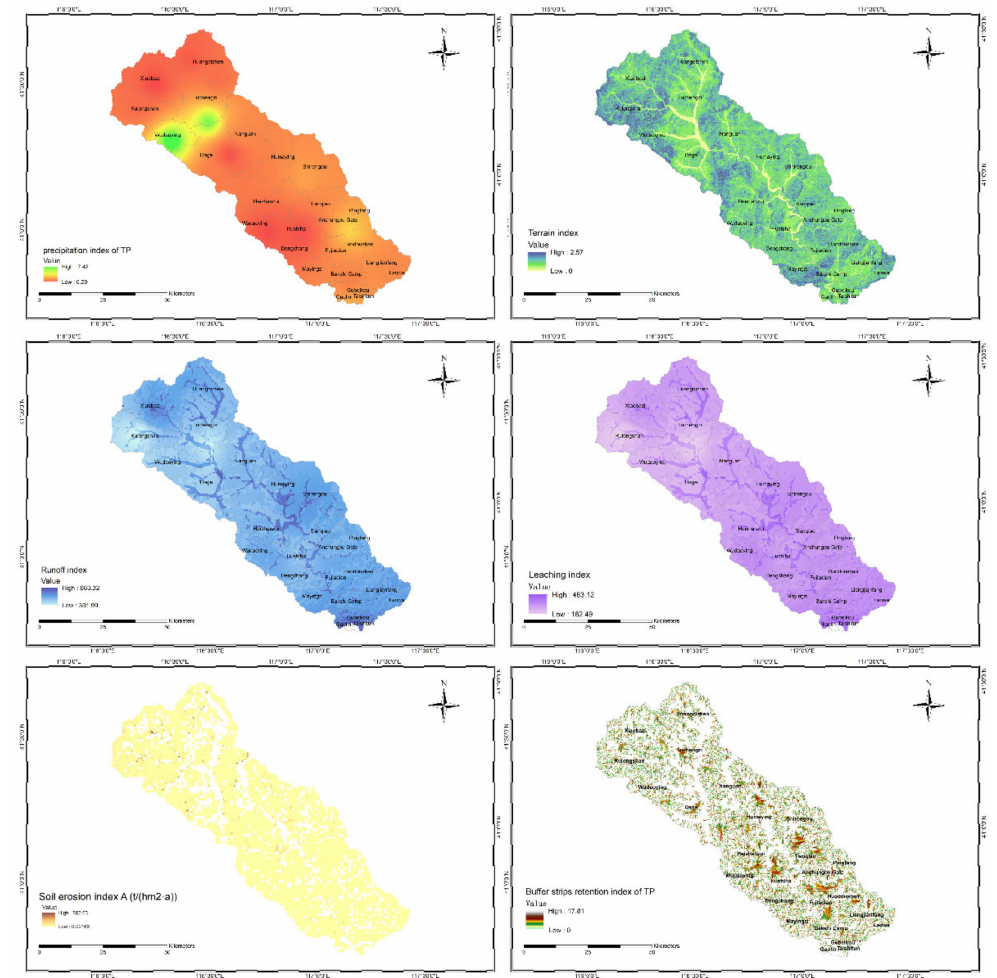
Figure 4. Spatial distribution of the five factors of NPS with respect to